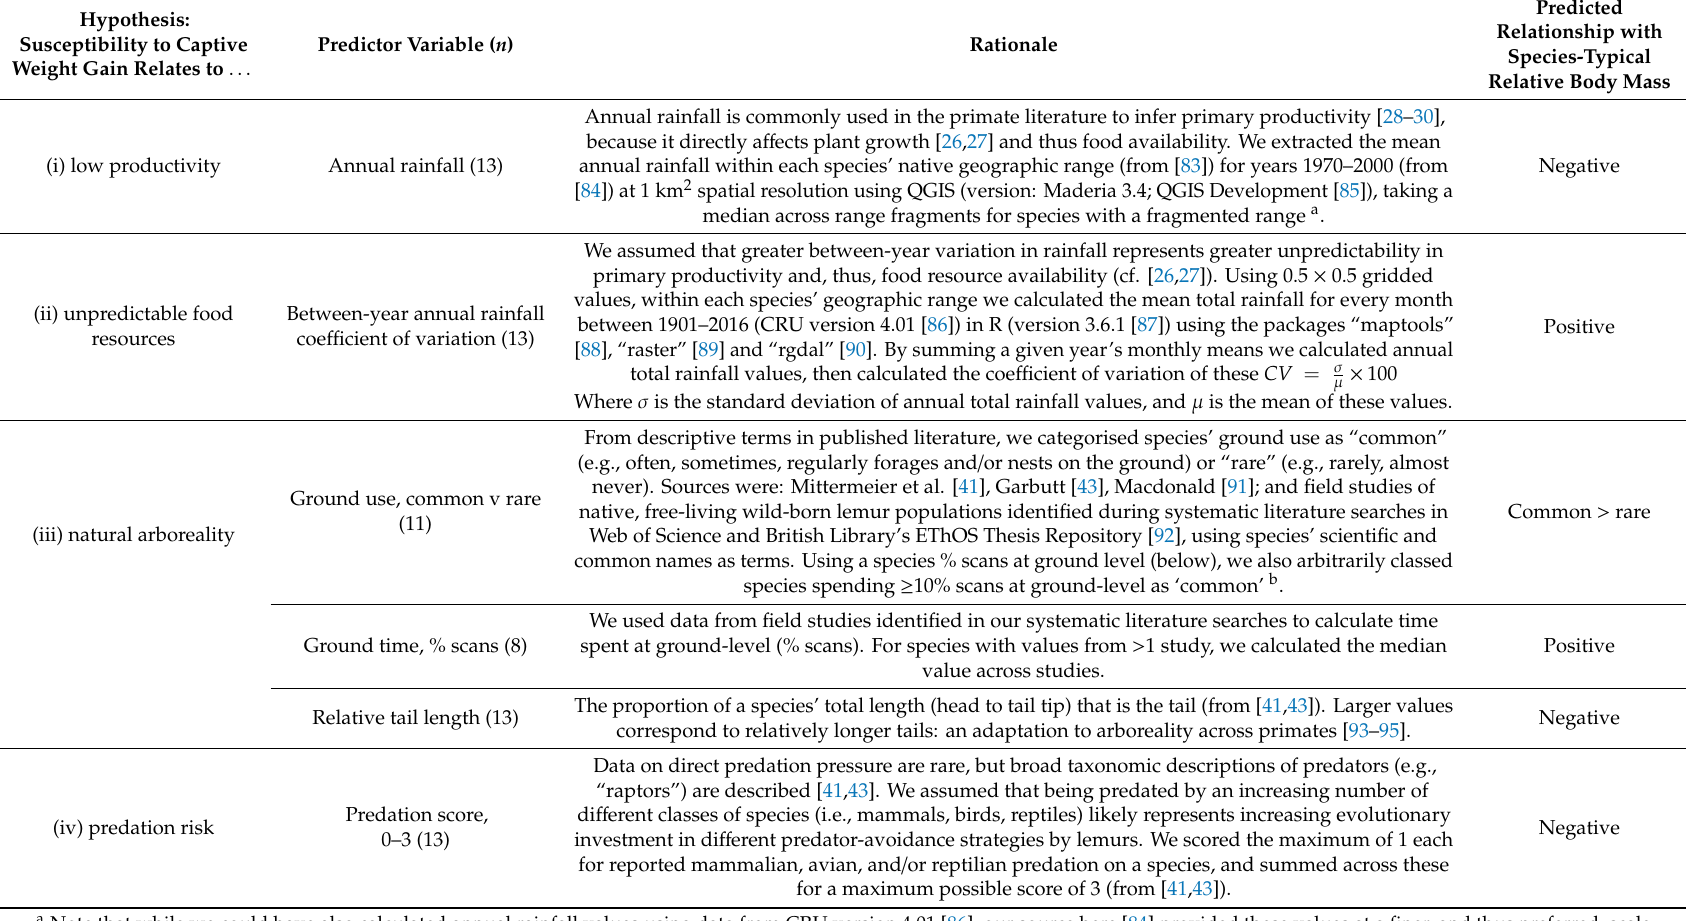
Table 2. Table describing predictor variables used to test our comparative hypotheses, their rationale, calculation, and predicted relationship with species-typical median relative body mass. n = number of species with